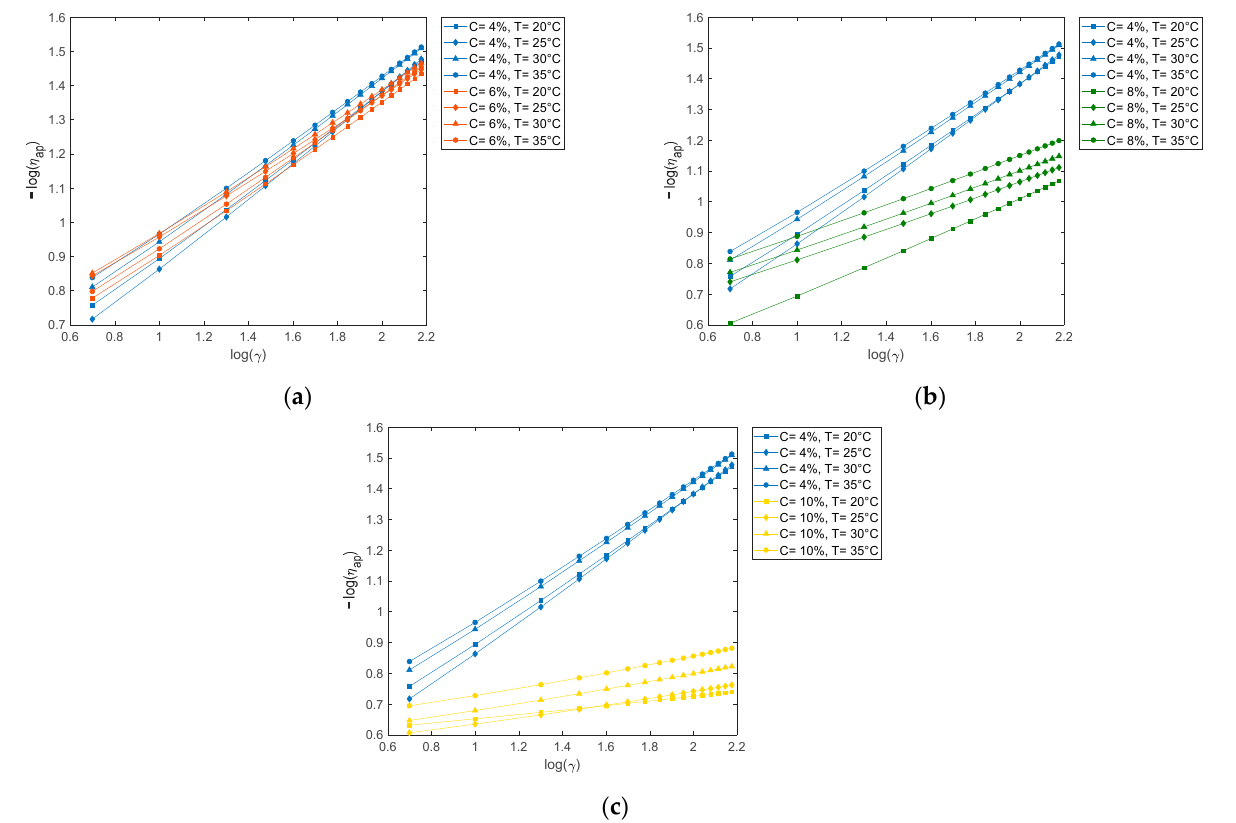
Figure 5. Compared apparent viscosity rheograms for 4% polyvinyl alcohol with respect to ( a ) 6, ( b ) 8, and ( c ) 10%.